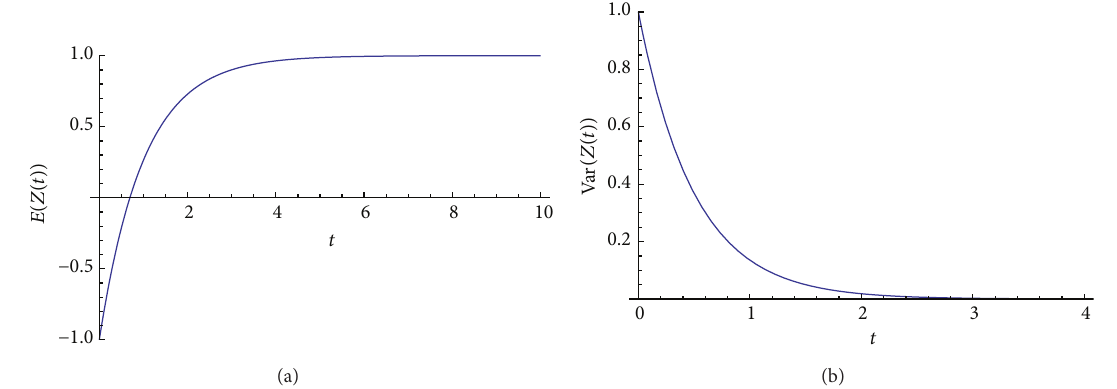
Figure 8: Expectation (a) and variance (b) of 𝑍(𝑡) given by (88) in Example 17 in the case that 𝜆 = 1 , 𝑡 0 = 0 , 𝑎 = −1 , and 𝑏 = 1 .